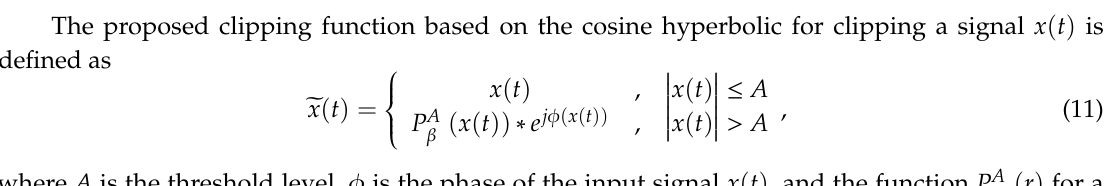
Figure 6. OFDM system transmitter side with Palm Clipping and the High-Power Amplifier (HPA). Palm Clipping Function P A β